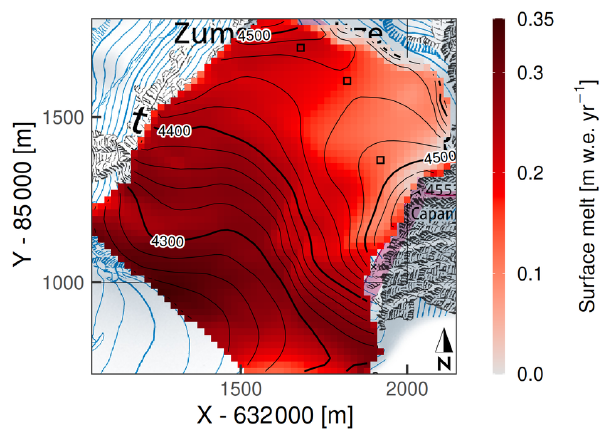
Figure 8. Mean (2003–2018) modeled annual melt amounts (20m grid, 1h time step). Marked cells correspond to the representative points of Fig. 1a. x and y are metric CH1903/LV03 coordinates. Topographic map source: Federal Office of Topography